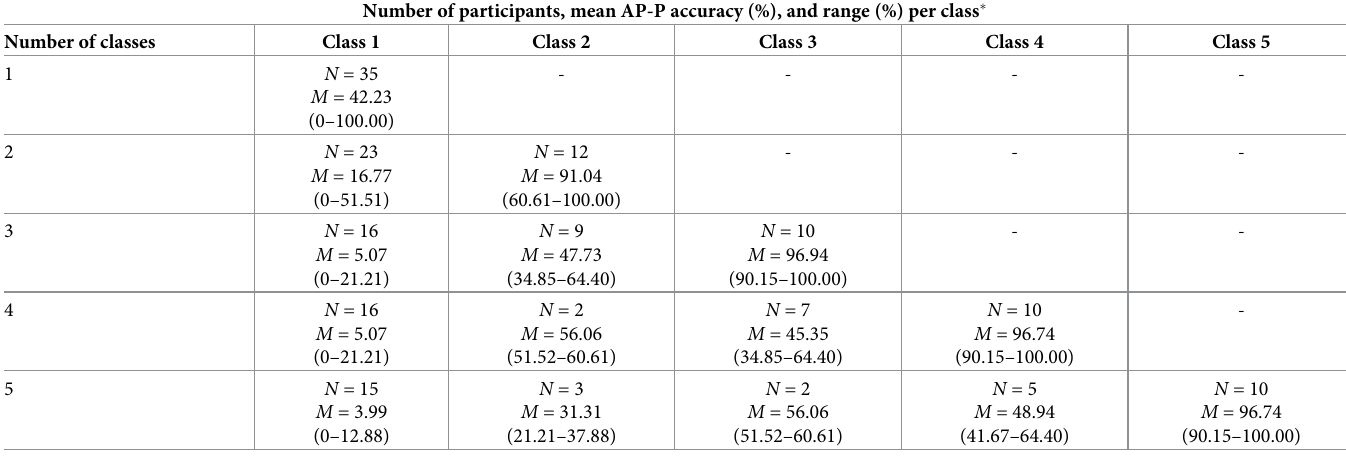
Table 4. Class characteristics in LPA models for